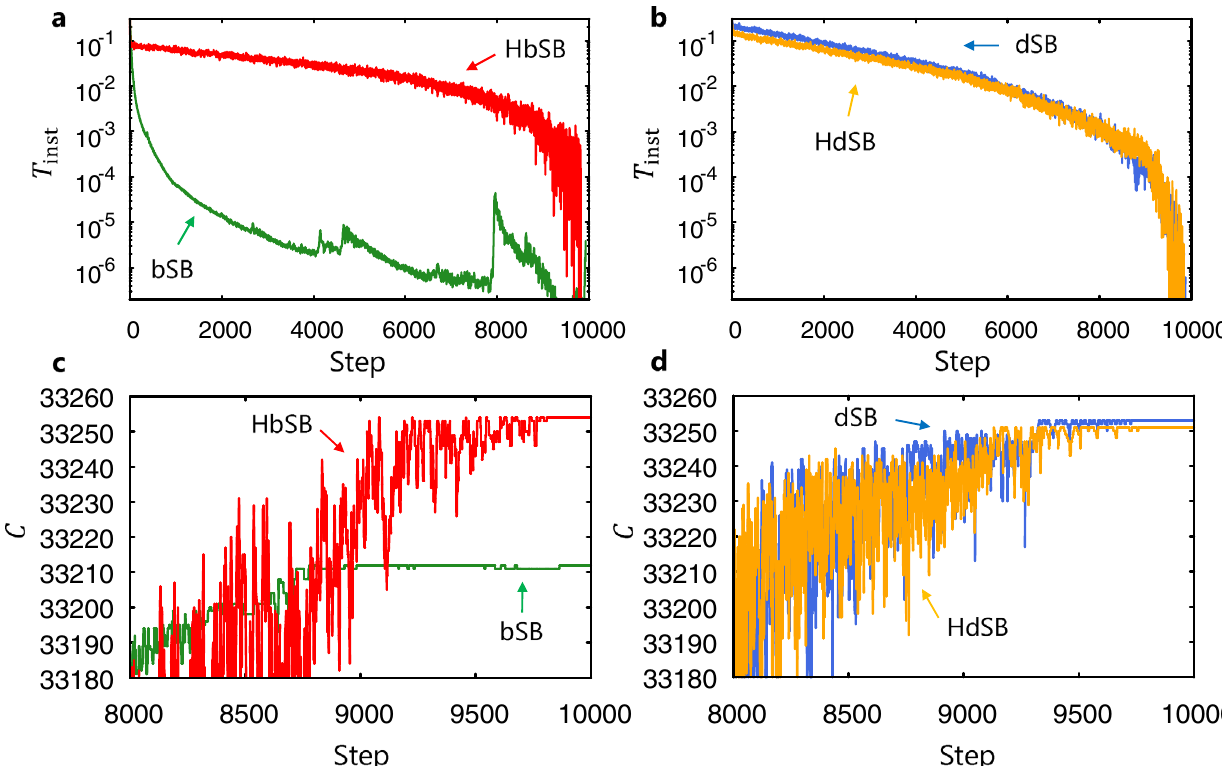
Fig. 1 Time evolutions in simulated bifurcation (SB) for a 2000-spin Ising problem (K 2000 ). a , b Instantaneous temperatures T inst . c , d Instantaneous cut values C . Here, bSB, dSB, HbSB, and HdSB denote ballistic SB, discrete SB, heated bSB, and heated dSB, respectively. Time is represented by time steps. Parameters are Δ t = 0.7 and c 1 = 0.6 for bSB, Δ t = 1.1 and c 1 = 0.6 for dSB, Δ t = 1.1, c 1 = 0.9 and γ = 0.5 for HbSB, and Δ t = 1.1, c 1 = 0.7 and γ = 0.06 for